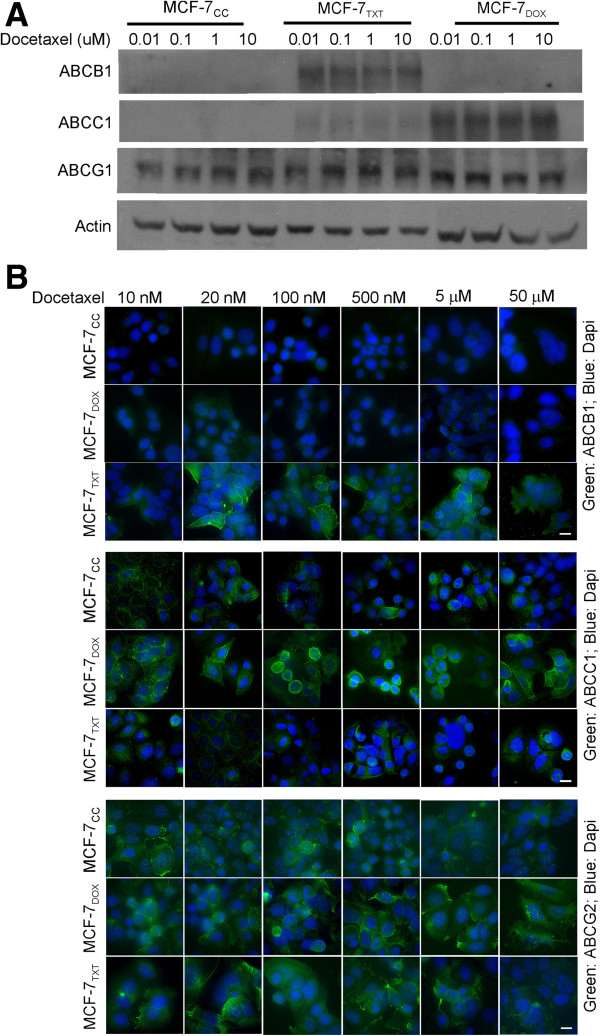
The effects of docetaxel treatment on the expression and localization of various ABC proteins in selected MCF-7 cell lines. (A) The effects of docetaxel on the expression of ABC proteins by immunoblotting. MCF-7CC, MCF-7TXT and MCF-7DOX cells were treated with docetaxel at indicated concentration for 24 hours. The cells were then lysed and expression level of ABCB1, ABCC1 and ABCG2 in the cells was examined by immunoblotting with specific antibodies. (B) The effects of docetaxel on the expression of ABC proteins by indirect immunofluorescence. MCF-7CC, MCF-7TXT and MCF-7DOX cells were seeded on coverslip and treated with docetaxel of indicated concentrations for 24 hours. The localization and expression of ABCB1, ABCC1 and ABCG2 in the cells were examined by indirect immunofluorescence. The green indicates the ABC proteins and the blue is the DAPI stain for nucleus. Size bar: 10 μm.